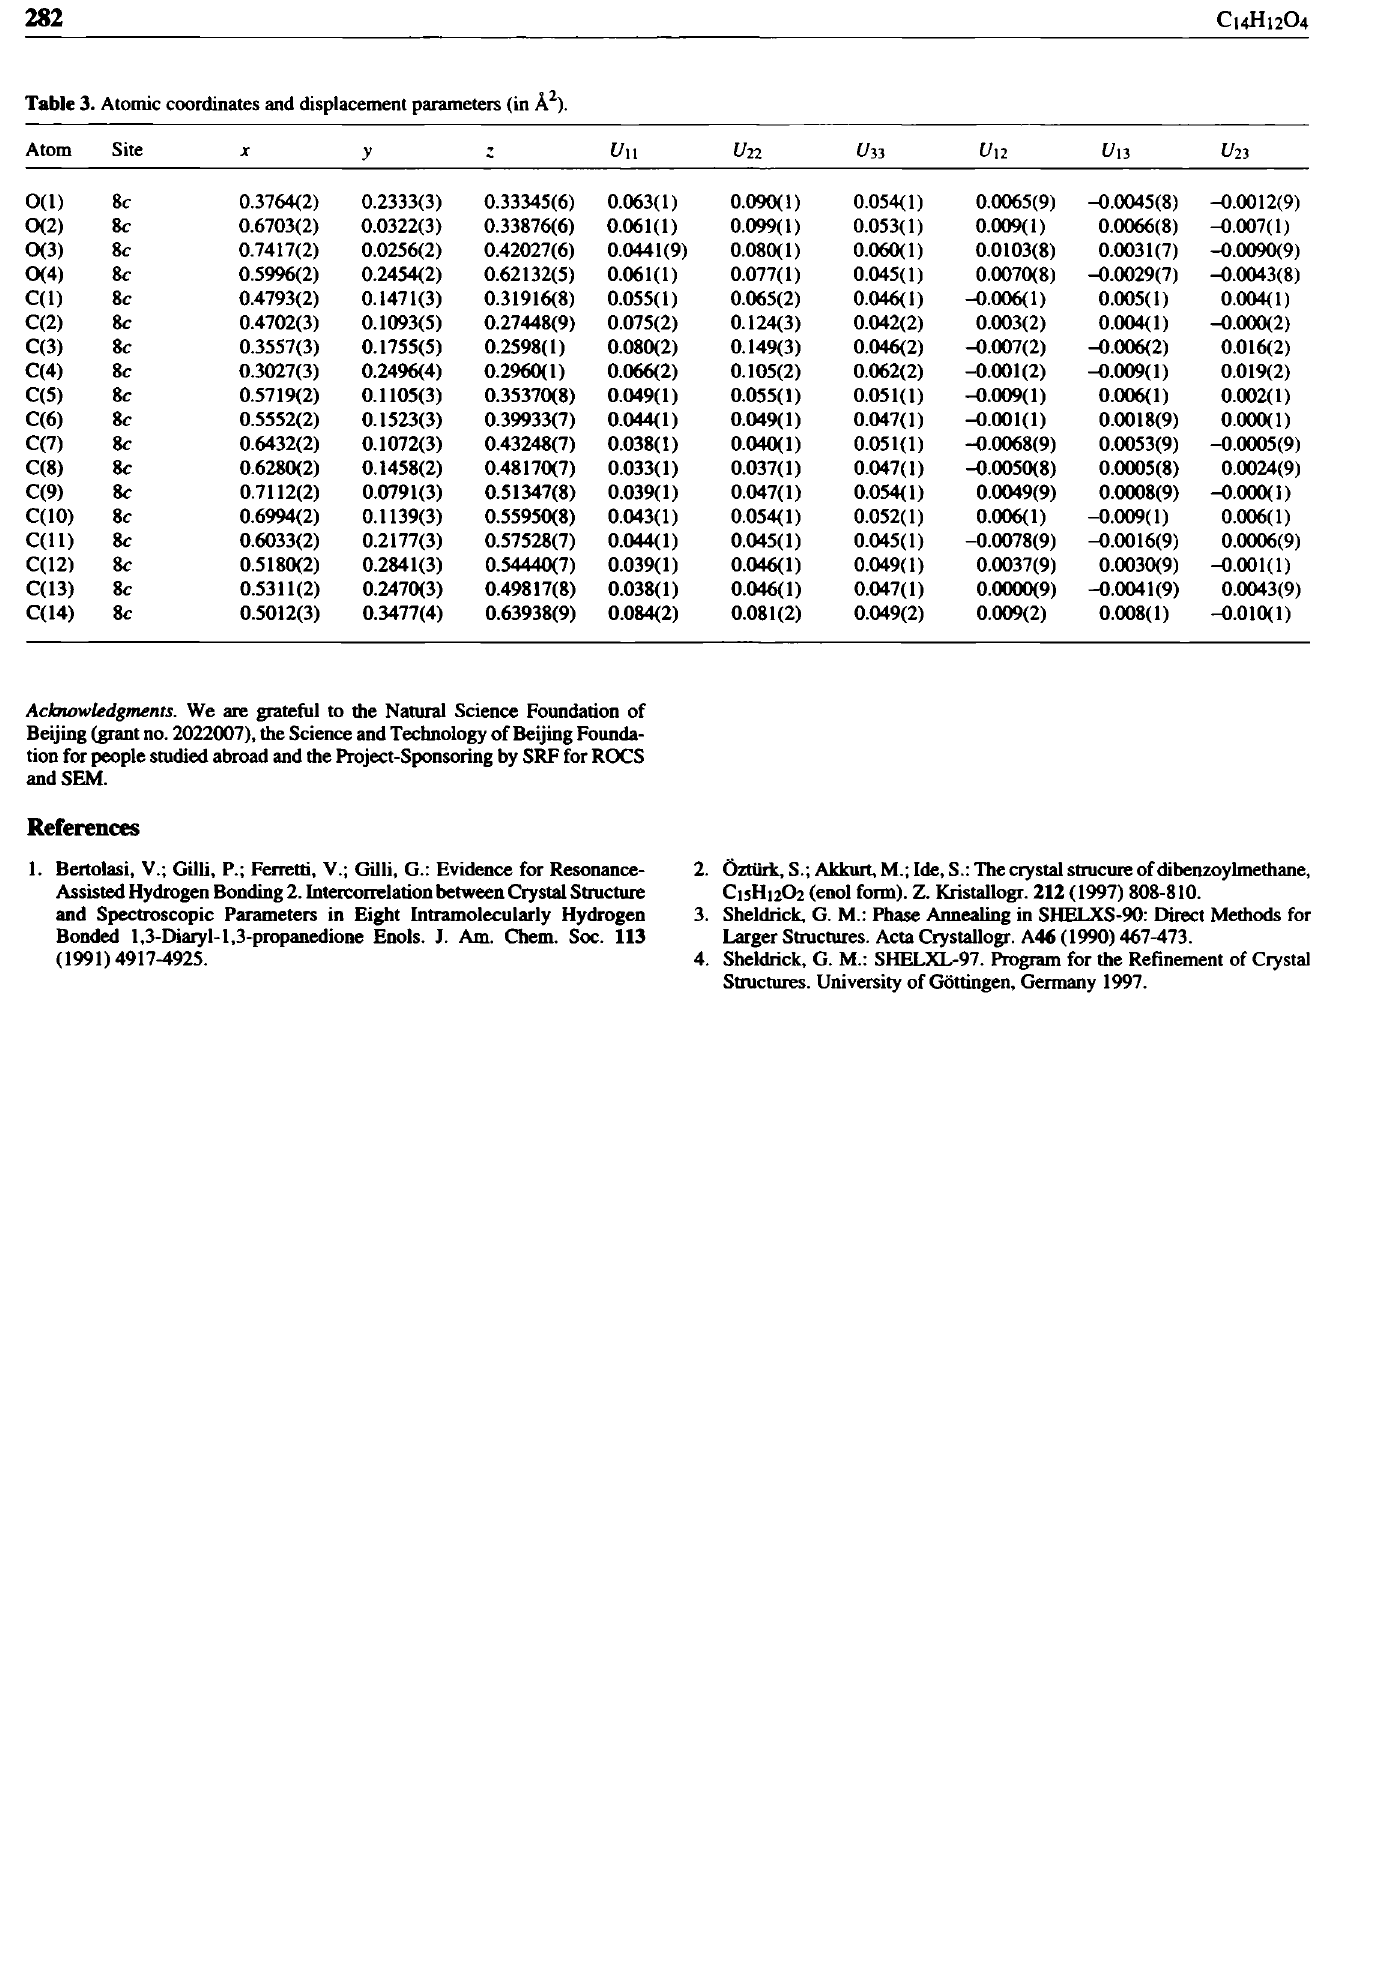
Table 3. Atomic coordinates and displacement parameters (in À 2